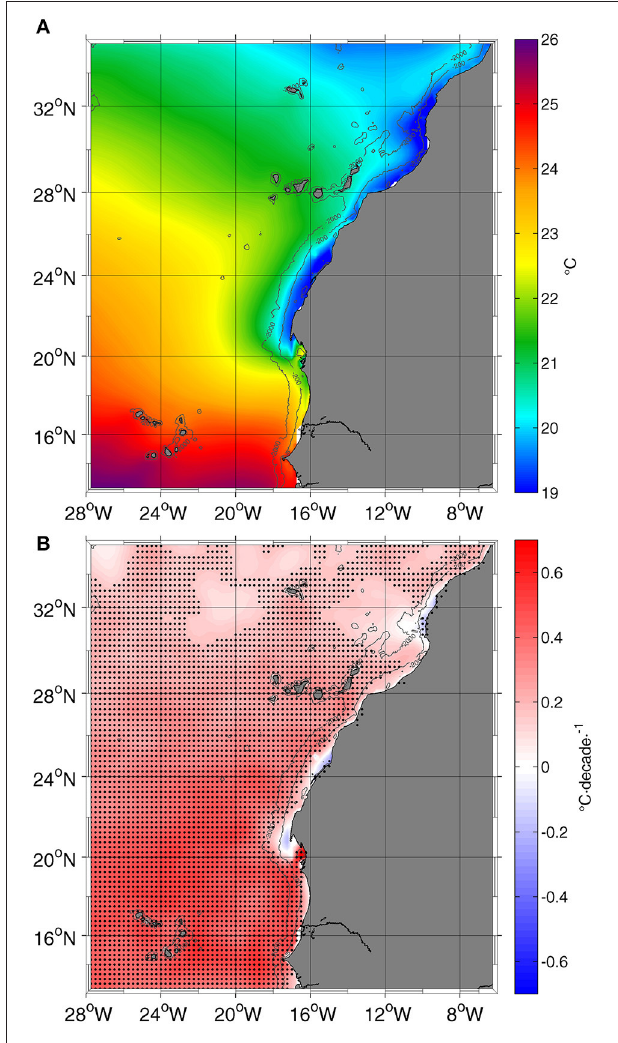
FIGURE 2 | Mean SST (A) and SST trend (B) for the 1993–2014 period. In (B) black dots correspond to significant trends ( p < 0.05). 200 and 2,000m isobaths are represented by gray contour